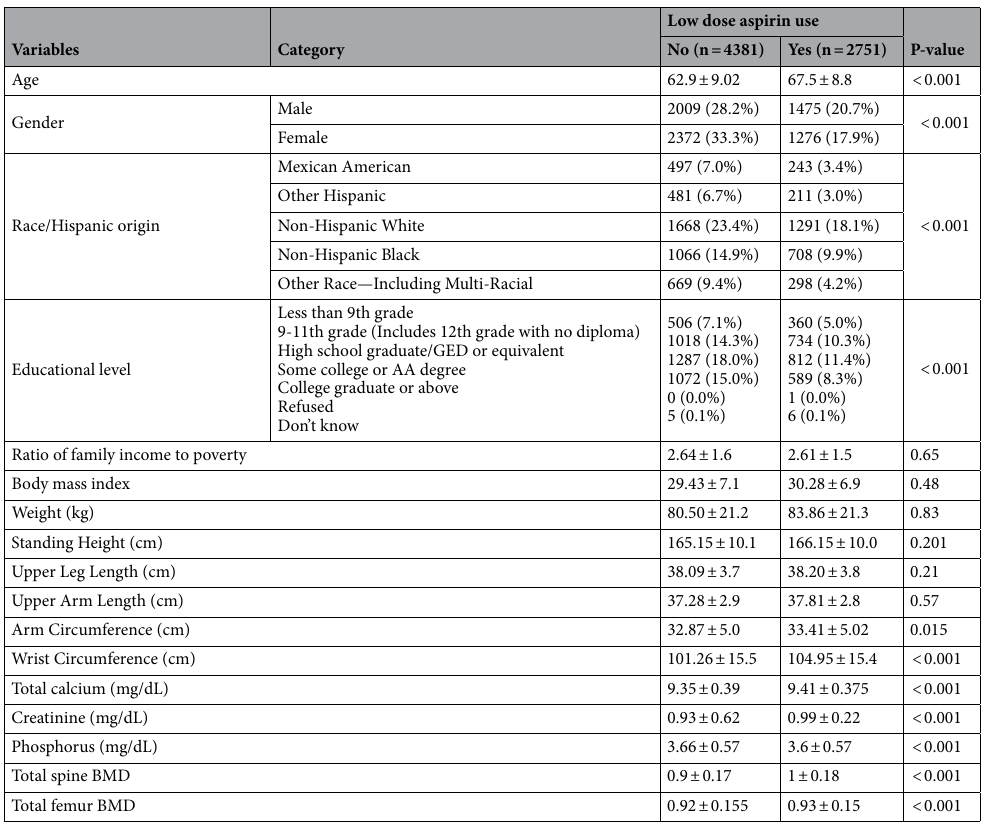
Table 2. Weighted Characteristics of Study Sample Non-aspirin users and low-dose aspirin users. (Mean ± SD for continuous variables: P value was calculated by weighted linear regression model. Percent for categorical variables: P value was calculated by weighted chi-square test).